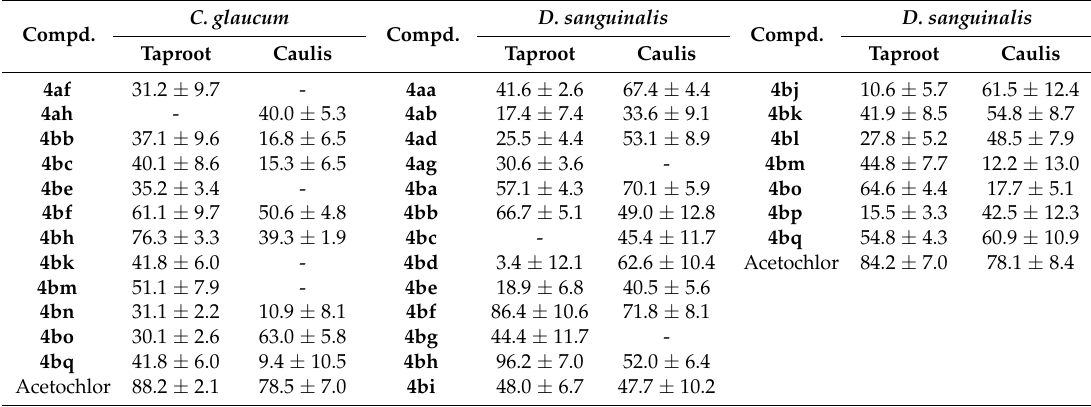
Table 2. Herbicidal activities of target compounds (%, 100 mg/L).